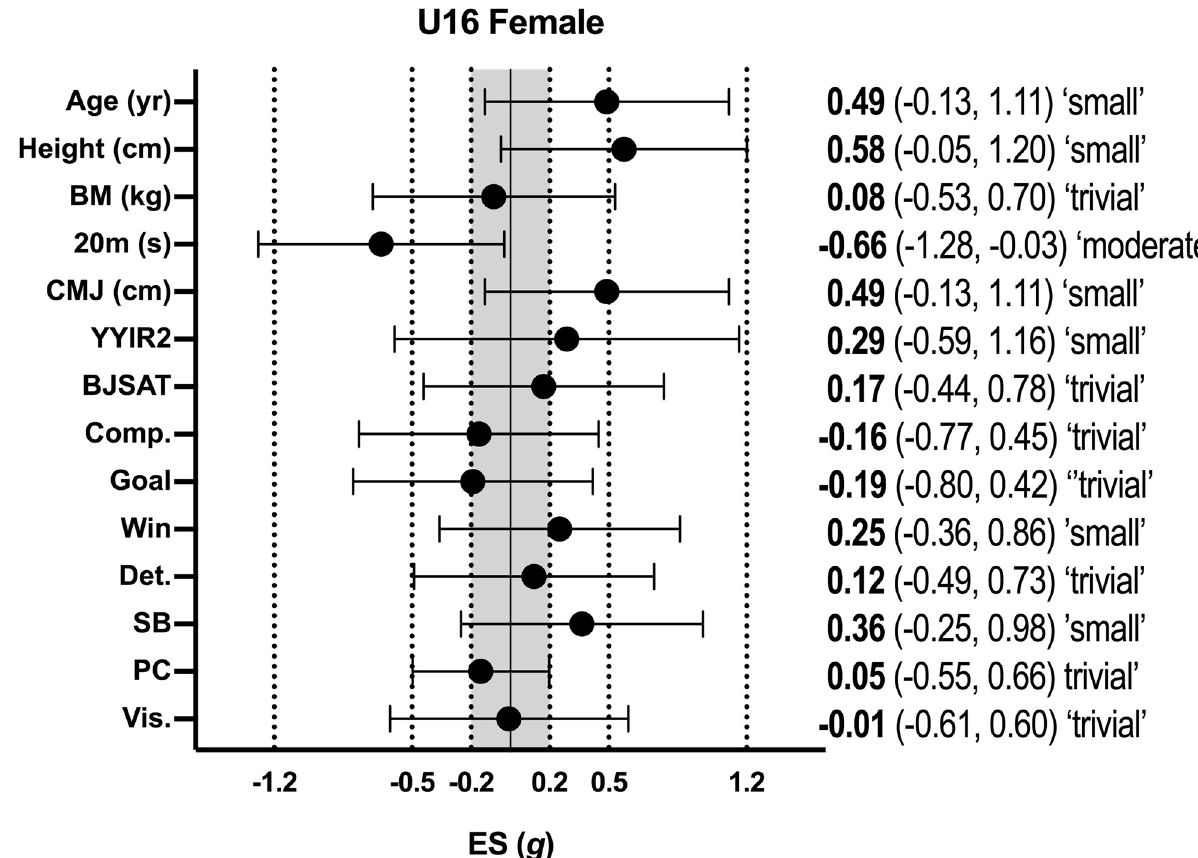
Fig 3. Effect sizes between selected and non-selected female U16 basketballers. BM–body mass; CMJ–countermovement jump; YYIR2 –Yo-Yo Intermittent Recovery Test Level 2; BJSAT–Basketball Jump Shooting Accuracy Test: DM–decision-making; Comp–competitiveness; Det.– determination; SB–self-belief; PC–positive cognition;